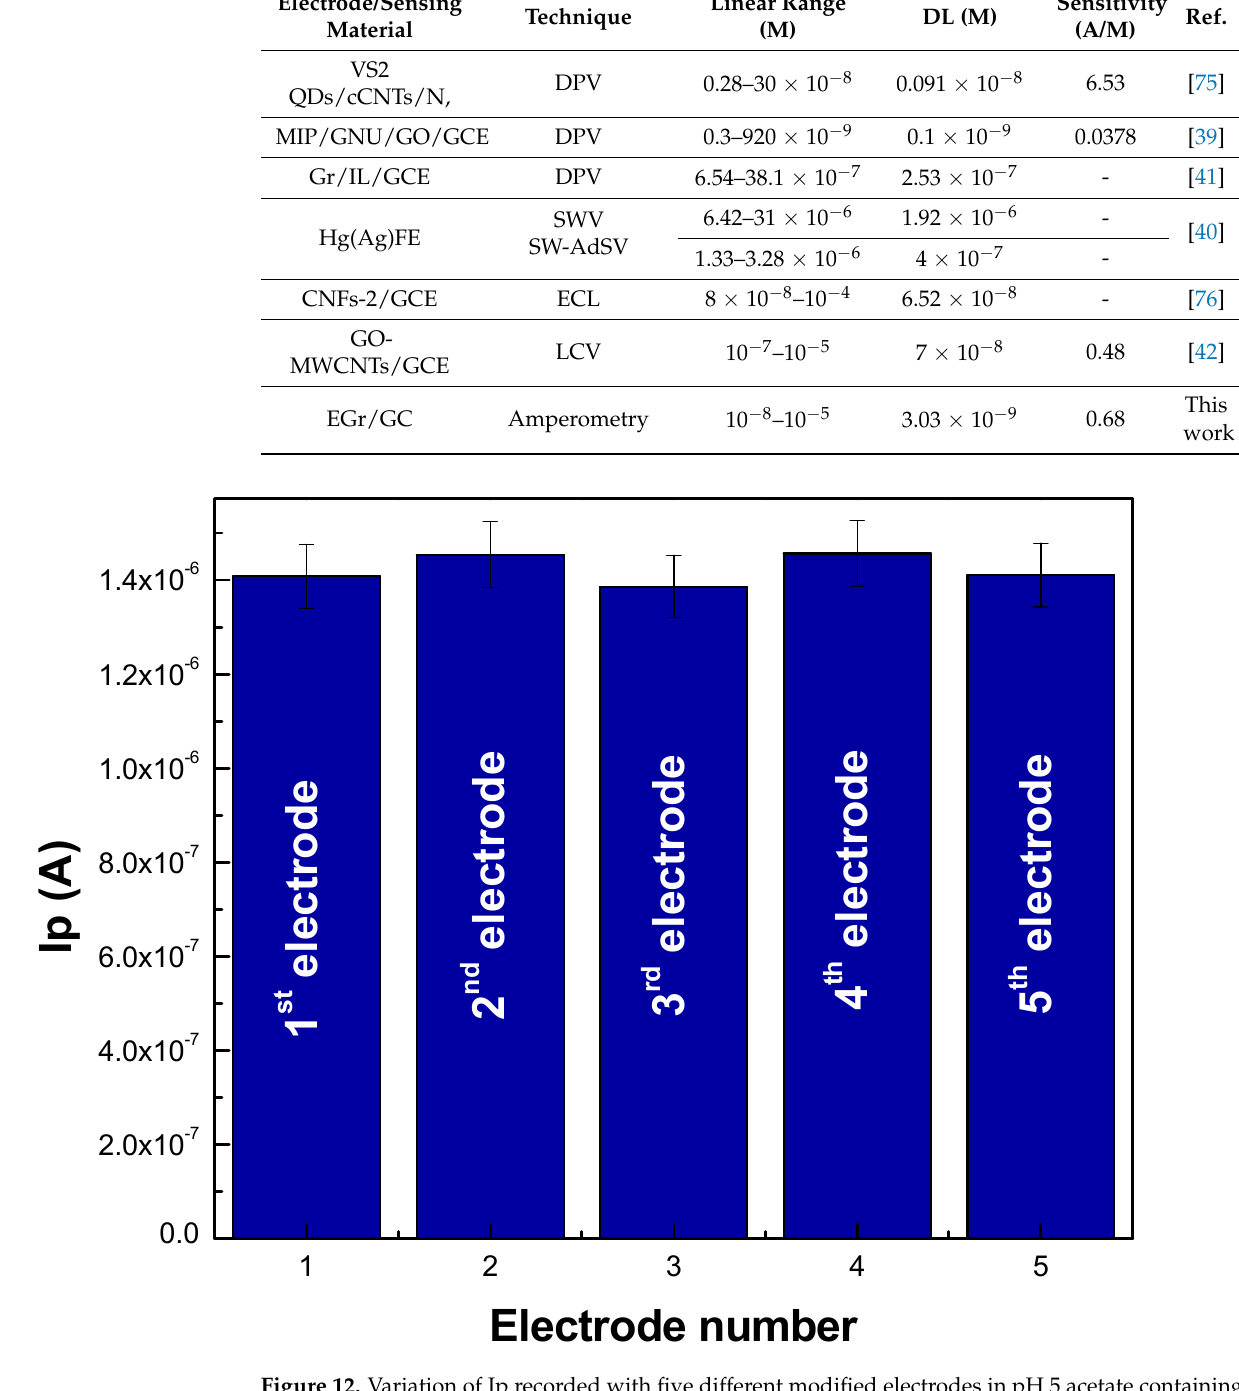
Figure 12. Variation of Ip recorded with five different modified electrodes in pH 5 acetate containing 6 × 10 − 5 M AZT.